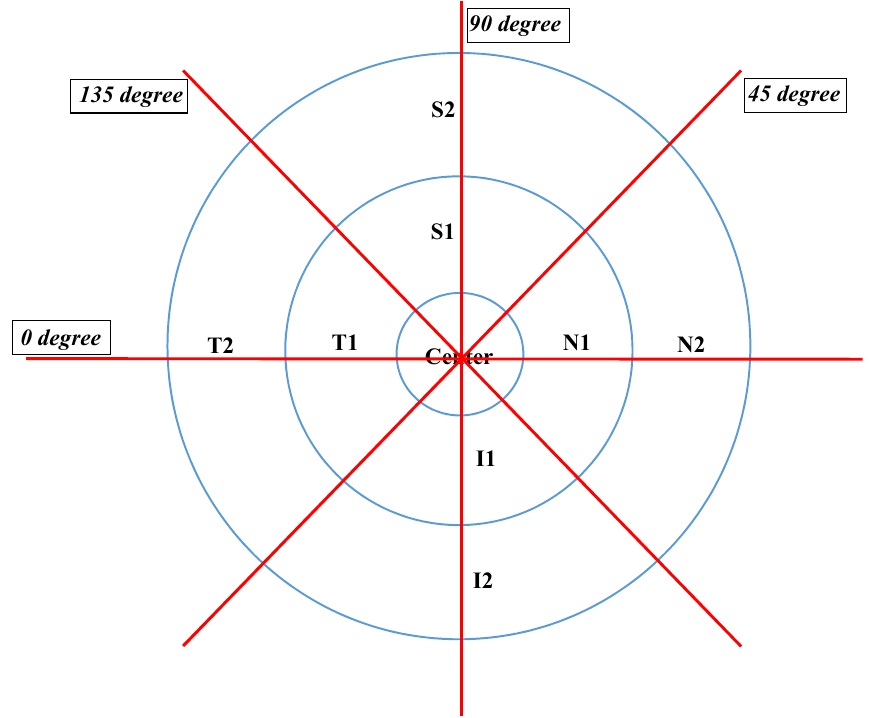
Figure 3. Schematic diagram showing axial scans from spectral-domain optical coherence tomography (SD-OCT) (Axial scan at 0°, 45°, 90° and 135°) in comparable with an Early Treatment Diabetic Retinopathy Study (ETDRS) grid (Diameters for central foveal circle, parafoveal circle and perifoveal circle are 1 mm, 3 mm and 6 mm, respectively). For SD-OCT, choroidal thickness of each regional sector was calculated from averaging thicknesses from 4 radial scans inside the central foveal circle for central foveal choroidal thickness (CFCT) (i.e. center area); or averaging thicknesses from 2 radial scans forming two linear edges of the annulus and 1 radial scan passing through the mid-point of the outer and inner circular edge for other regional sectors (i.e. S1, S2, I1, I2, T1, T2, N1 and N2).